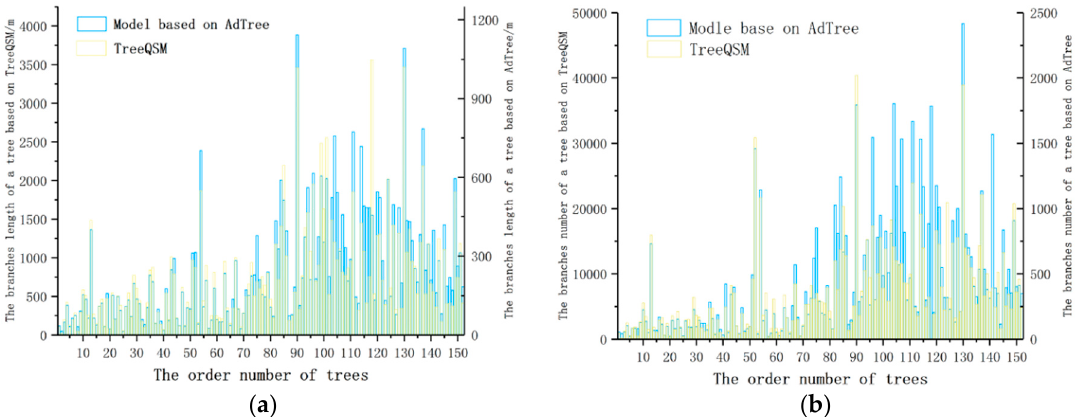
Figure 17. Number and length distribution of branches of each tree. ( a ) Length of branches; ( b ) number of branches.